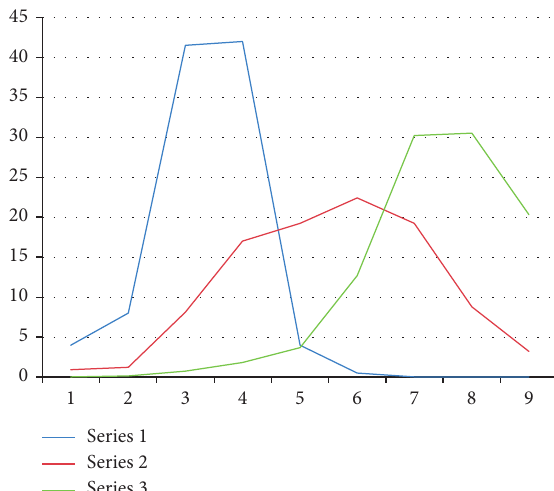
Figure 2: The comparison between HAV and COVID-19. The age- specific distribution of HAV morbidity rate in 1988 in Shanghai (series 1), COVID-19 morbidity rate (series 2), and COVID-19 death rate (series 3) in